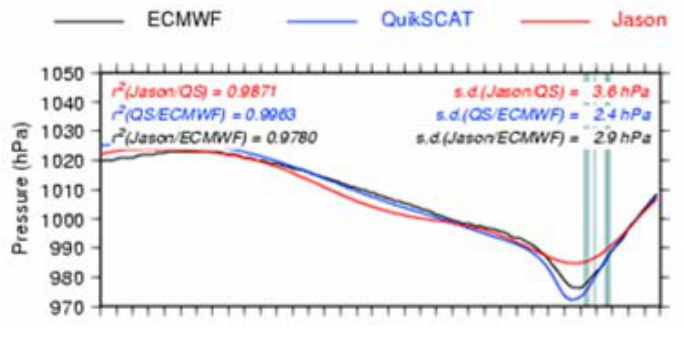
Figure 13. Comparison of the along-track SLP for the ETD of 21/03/2004 5:12 UTC QuikSCAT time. The abscissa shows the along-track distance in km (one stick every 100 km).